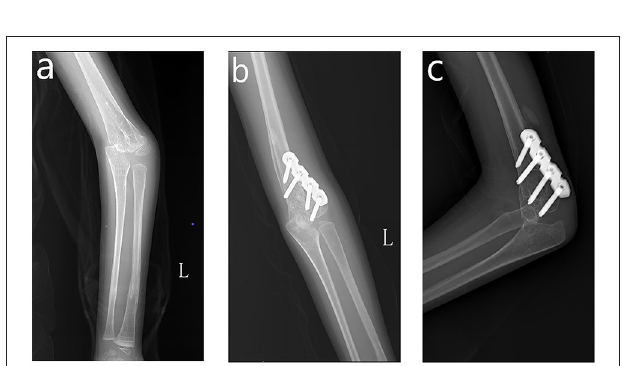
FIGURE 2 | Radiograph of fractures in lower extremity. (a) Full-length image of the lower extremities showing fracture and bowing in bilateral femur. (b) Nailing of the right femur. (c) Nailing of the left femur.